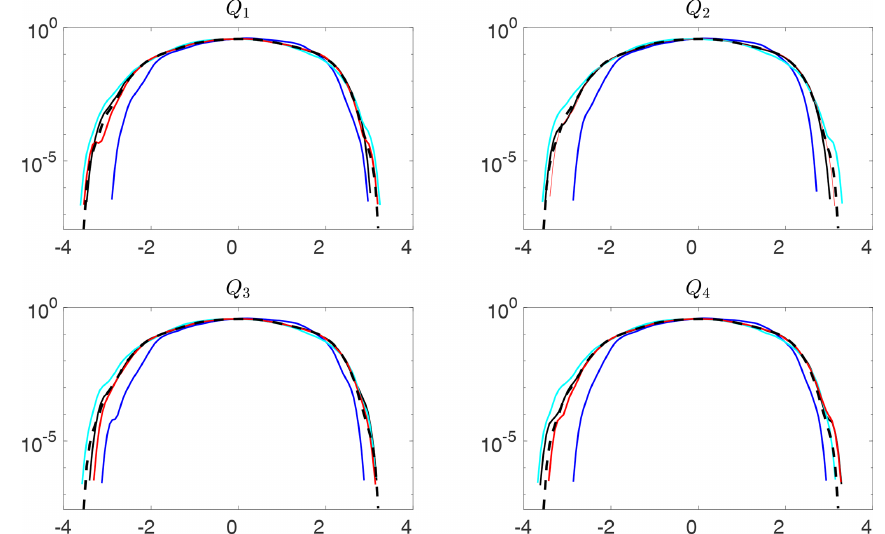
Figure 9. Estimated probability density functions (pdf’s) of long datasets freely predicted by using RC–ESN (red), ANN (blue), and RNN– LSTM (cyan) compared to the true pdf (broken black). RC–ESN, ANN, and RNN–LSTM are first trained with N = 500000 and then predict, from an initial condition, for 4 × 10 6 (cid:49)t . Panels Q 1 − Q 4 correspond to the equally divided quartiles of 10 6 predicted samples. The pdf’s are approximated using kernel density estimation (Epanechnikov, 1969). The green lines show the estimated pdf’s from different sets of 10 6 samples that are obtained from the numerical solution of Eqs. (1)–(3). Small differences between the green lines show the uncertainties in estimating the tails from 10 6 samples. The broken black lines show the true pdf estimated from 10 7 samples from the numerical solution. Note that the presented pdf’s are for standardized